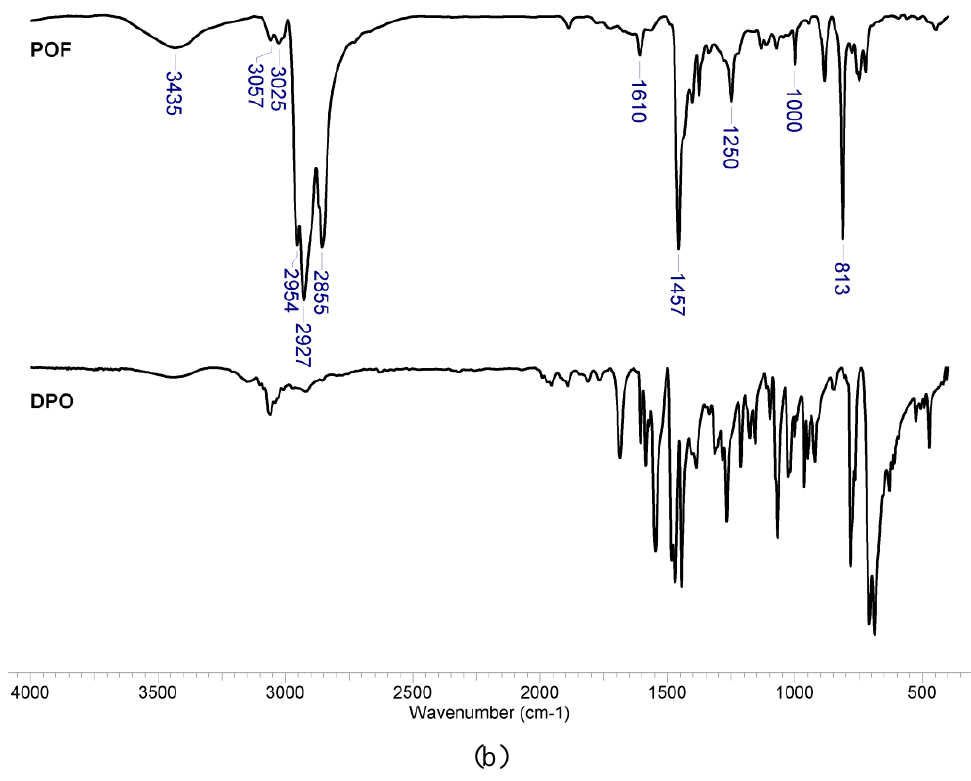
Figure 1. 1 H-NMR ( a ) and FTIR ( b ) spectra of the POF polymer and precursor monomers.